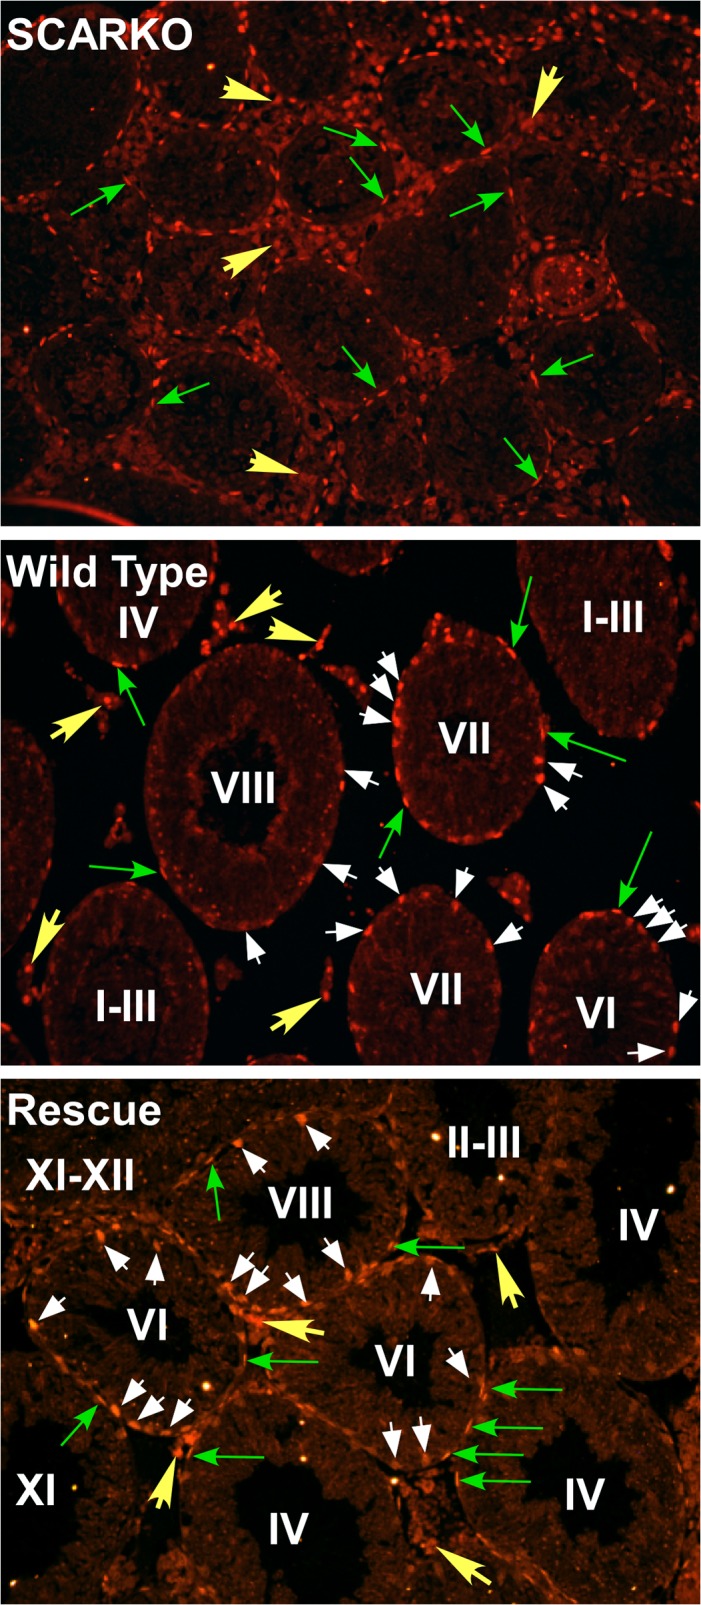
AR is expressed stage-specifically in Sertoli cells of rescue mice.Testis cross sections from SCARKO, wild type and rescue mice were probed with antisera against AR. Long green arrows denote AR immunostaining (red immunofluorescence) in peritubular cell nuclei. Short yellow arrows show AR expression in Leydig cells. White arrowheads denote AR immunostaining in Sertoli cell nuclei. Stages of the seminiferous epithelium for tubule cross sections are denoted by Roman numerals (I-XII). Bar = 100 μm, magnification: 20x objective.